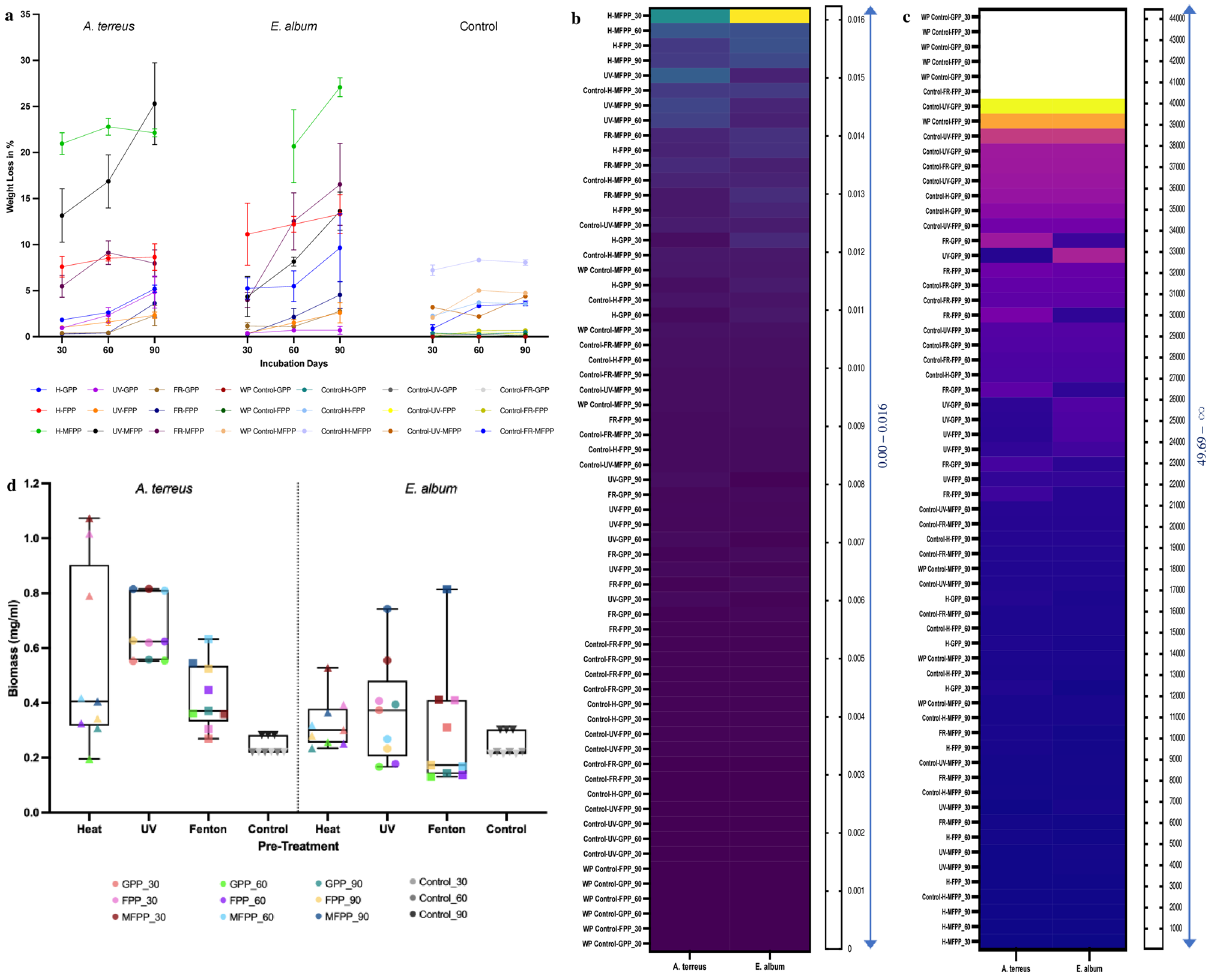
Fig. 2 Physical assessment of PP and biomass production of A. terreus and E. album . a Percentage gravimetric weight loss of the pre- treated and untreated GPP, FPP, and MFPP incubated with A. terreus and E. album at the end of 30, 60, and 90 days. The error bars represent the standard error of mean (sem) of the triplicate reading for the gravimetric weight loss percentage. b , c Heat map of the mass reduction ef fi ciency of A. terreus and E. album in GPP, FPP, MFPP and controls-infused mineral salt media (details in Supplementary Table 2). d Biomass production of 30, 60, and 90 days inoculation of A. terreus and E. album with pre-treated GPP, FPP, and MFPP and biotic control (MSM + A. terreus or E. album ). GPP PP granule; FPP PP fi lm, MFPP PP metallised fi lm, GPP PP granule, FPP PP fi lm, MFPP PP metallized fi lm, WP Control without pre-treatment control, UV UV treatment, H heat treatment, FR Fenton reagent treatment. Within each box, horizontal black lines denote median values; the boundary of the box closest to 0 indicates the 25 th percentile while the value farthest from 0 indicates the 75 th percentile; whiskers extending from top to bottom of the box indicate the 10 th and 90 th percentiles; the top end of the whiskers indicate the maximum value while the lowest end indicates the minimum value of the